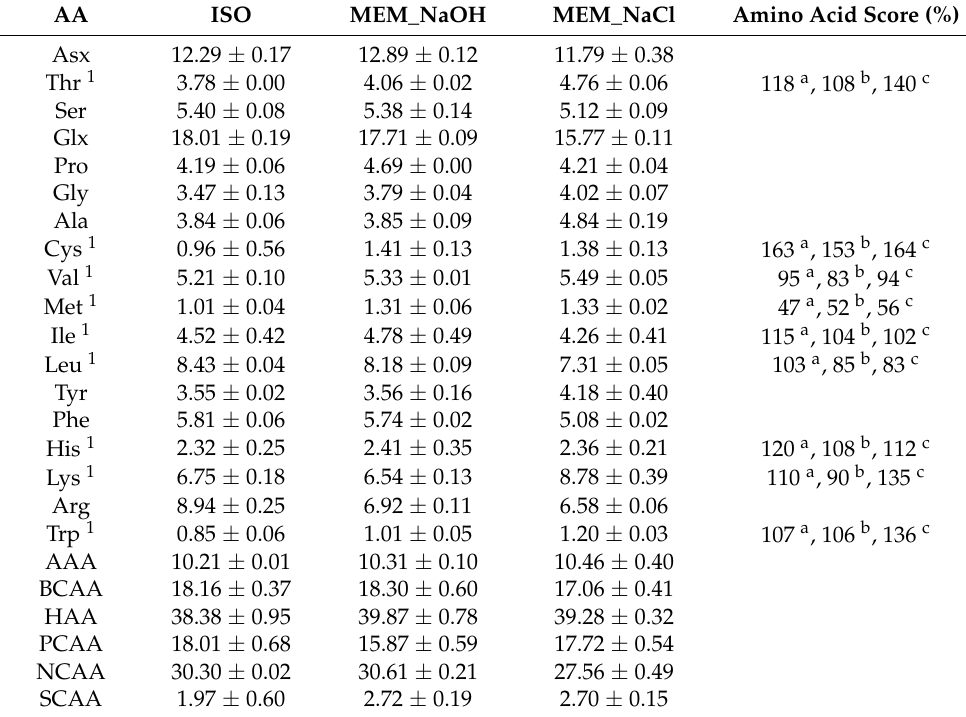
Table 2. Percentage amino acid composition of lentil seed protein isolates